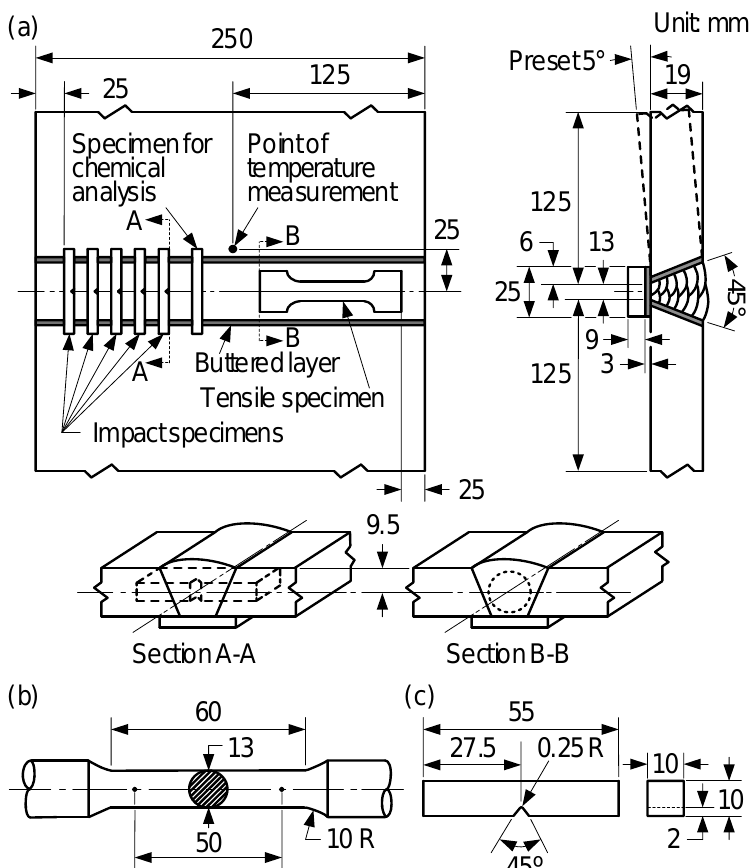
Figure 1. Groove weld test assembly and pass arrangement for evaluation of mechanical properties and dimensions of test specimens: ( a ) test plate showing locations and pass arrangement of test specimens; ( b ) dimensions of round tensile specimen; ( c ) dimensions of Charpy V-notch impact specimen [2].